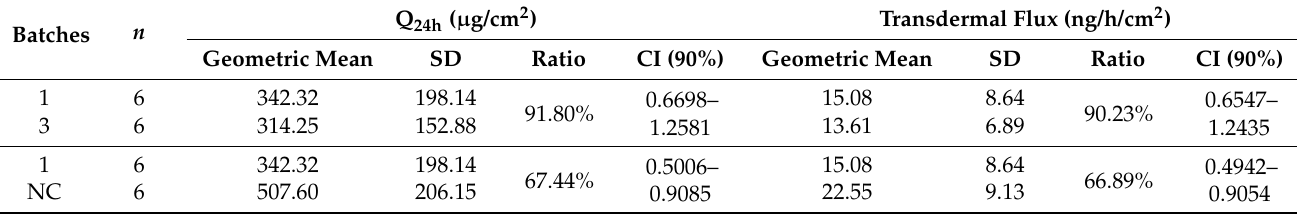
Figure 11. Permeation profile of batches 1 and 3 of the capsaicin emulsion at 0.025% w / w and negative control (0.05% w / w ). Dose in the donor compartment = 50 mg/cm 2 . Table 8. The 90% confidence intervals (CIs) of permeation parameters (released amount of capsaicin at 24 h (Q 24h ) and transdermal flux) of batches one and three of capsaicin emulsion at 0.025% w / w and the negative control (0.05% w / w ). SD: standard deviation.